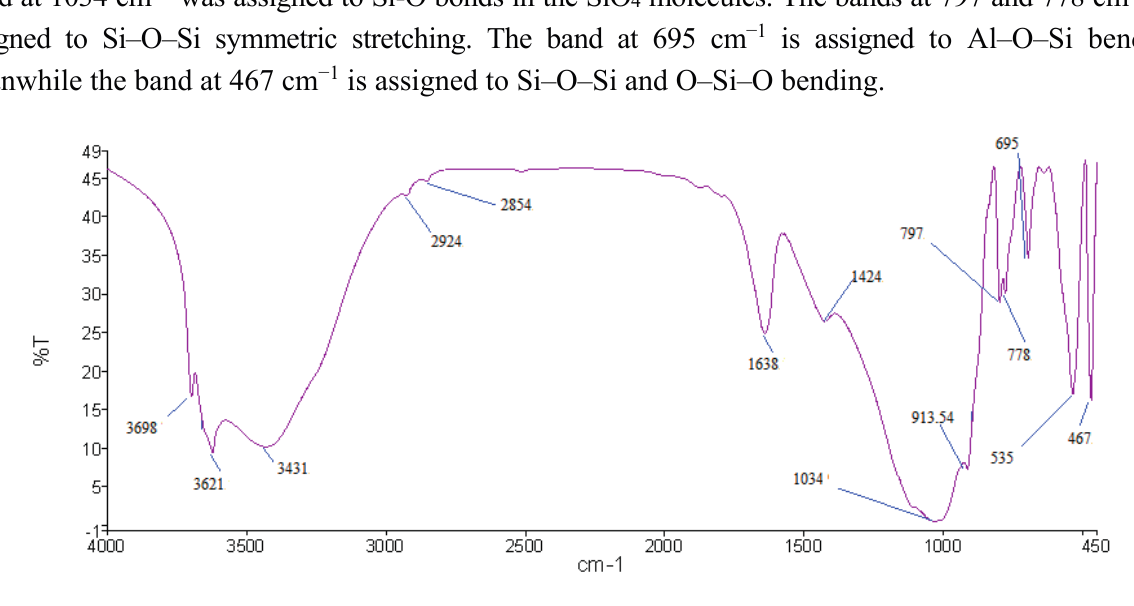
Figure 13. FTIR spectrum of LUSI